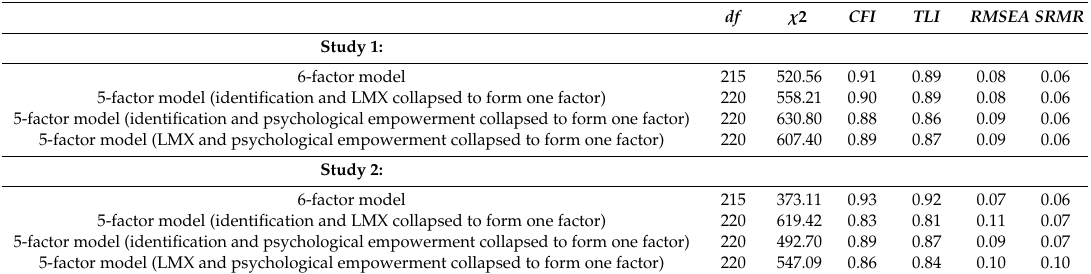
Table 1. Results of the Measurement Model Confirmatory Factor Analyses.